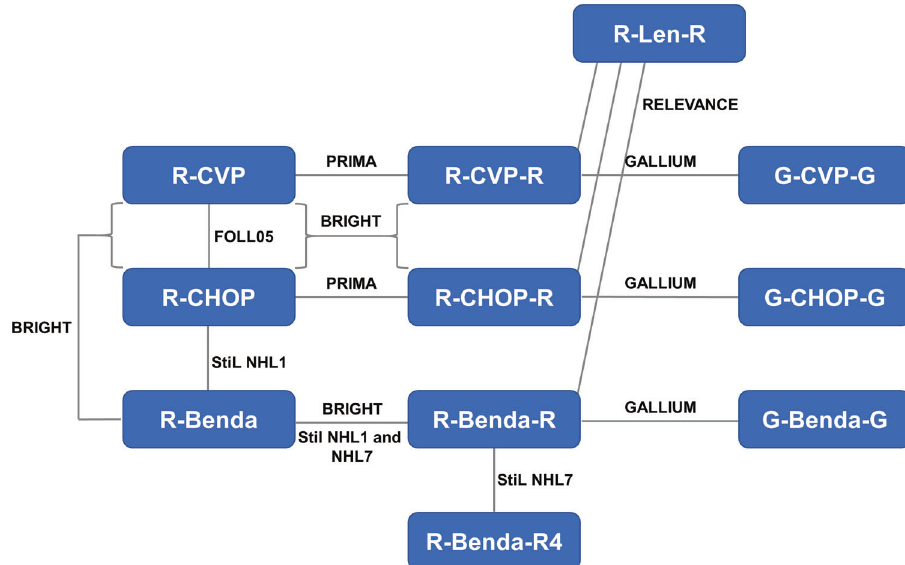
Fig. 2 Network of comparisons included in the network meta-analysis.